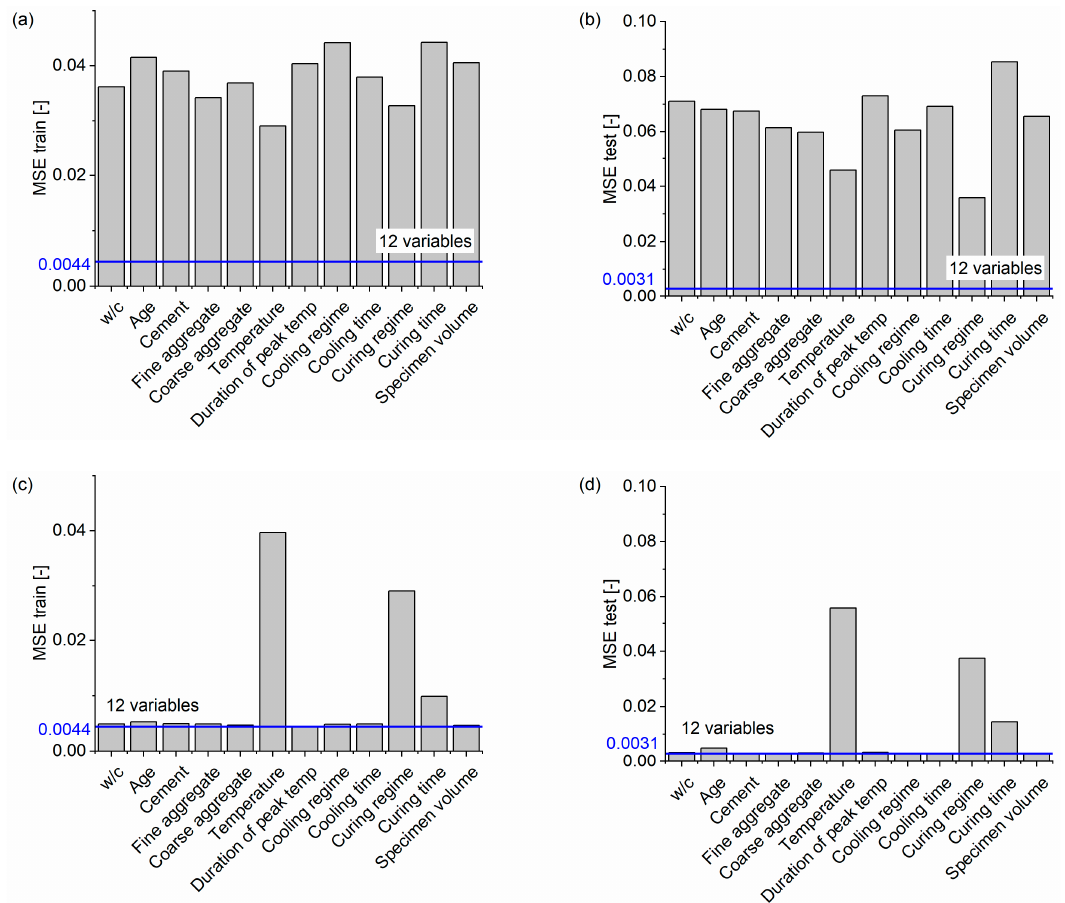
Figure 13. Performance of the model with a different number of variables: ( a ) trained only on one variable, MSE for the training set; ( b ) trained only on one variable, MSE for the testing set; ( c ) trained on 11 variables with one variable removed, MSE for the training set; ( d ) trained on 11 variables with one variable removed, MSE for the testing set.